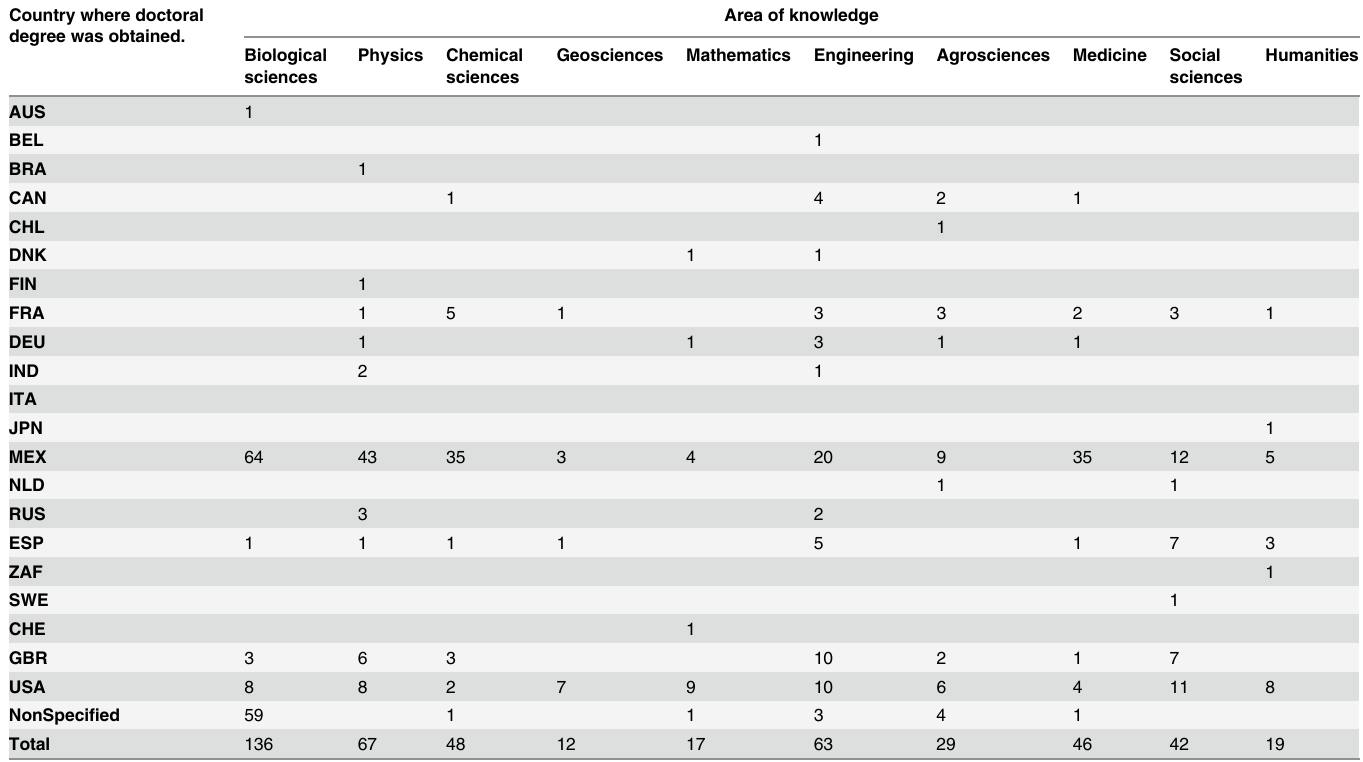
Table 2. Distribution of researchers in the scientific Mexican Diaspora by country where they obtained their PhD degree (2013). Country where doctoral degree was